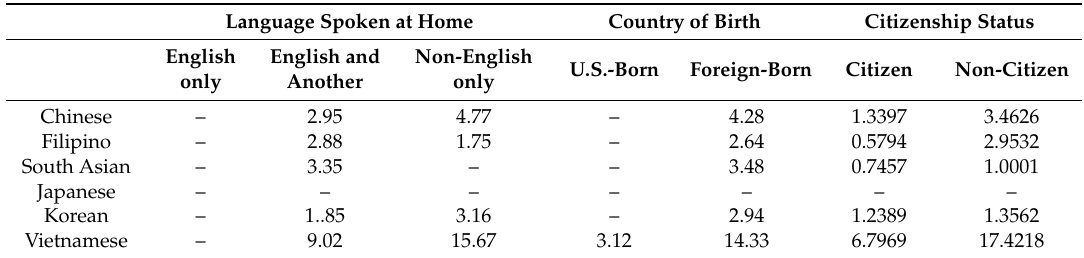
Table 4. Prevalence of SNAP participation among Asian American